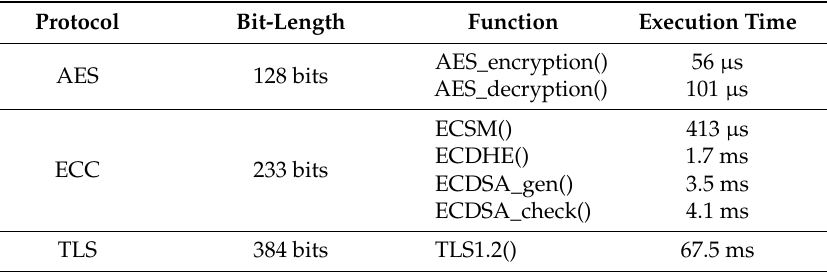
Table 4. Execution time of the involved crypto functions for TLS